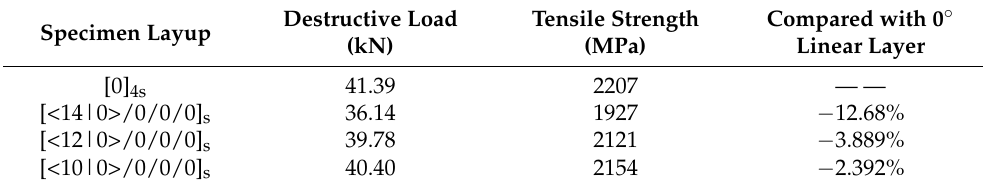
Table 1. Tensile strength of different geodesic curvature curve layers and 0 ◦ linear layer